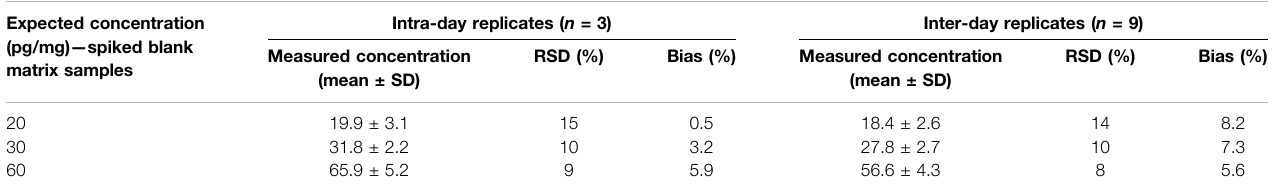
TABLE 4 | Validation results for EtG in human hair samples in GC-MS/MS. Expected concentration (pg/mg) — spiked blank matrix